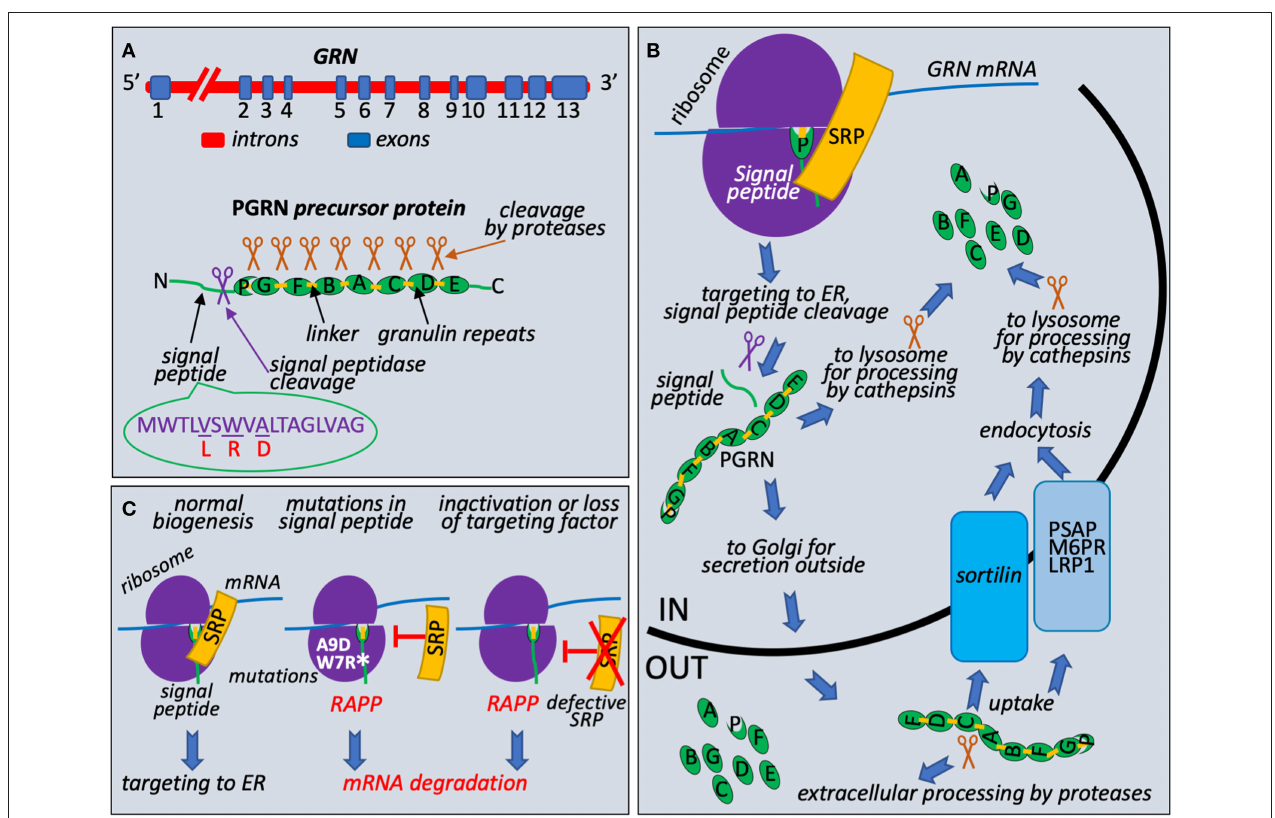
FIGURE 1 | Granulin biogenesis, quality control at the ribosome during its synthesis, and molecular mechanism of FTLD associated with mutations in the signal peptide of the granulin precursor. (A) Schematic presentation of GRN , precursor protein structure, and known missense mutations in the signal peptide. Progranulin pre-mRNA transcript is synthesized in the nucleus from GRN gene in the chromosome 17. It has 13 exons with exons 2–13 containing protein coding region. After splicing, mRNA is exported to cytoplasm for translation. Progranulin precursor (63.5 kDa protein) consists of N-terminal cleavable signal peptide (green line with indicated position of the cleavage by the signal peptidase shown as purple scissors) and 7.5 repeats (green ovals): P (half-repeat, paragranulin), G (granulin 1), F (granulin 2), B (granulin 3), A (granulin 4), C (granulin 5), D (granulin 6), and E (granulin 7). Repeats are connected by linker sequences (light orange boxes). Proteases are shown as brown scissors. Signal peptide sequence presented with known missense mutations L (V5L), R (W7R), D (A9D), corresponding amino acid residues in the wild-type signal peptide are underlined. (B) PGRN protein trafficking and processing. During early translation step on the ribosome (purple hemispheres), N-terminal signal peptide of progranulin (green line) is recognized by Signal Recognition Particle (SRP) (shown in orange) and ribosome-nascent chain complex is targeted to ER for signal peptide cleavage (purple scissors), posttranslational modifications, and further processing and transport. Full length protein could be processed to 6 kDa granulins in lysosomes by cathepsins (brown scissors are symbols for all proteases involved in posttranslational processing) or secreted outside and undergo extracellular processing. Uptake of full-length protein is governed by endocytosis with the help of sortilin receptor (blue box) or through alternative PSAP (prosaposin)-dependent pathway with involvement of mannose 6-phosphate receptor (M6PR) and low density lipoprotein receptor-related protein 1 (LRP1) (gray blue box). (C) Loss of interaction with targeting factor, SRP, activates RAPP pathway. During normal translational event, PGRN with N-terminal signal sequence is targeted to ER through interaction with SRP. Amino acid sequence of signal peptide and location of reported clinical mutations are shown on (A) . When A9D or W7R mutations in signal peptide is detected or SRP is defective or lost, nascent chain is no longer targeted to ER by SRP. It leads to the RAPP pathway activation and degradation of the GRN